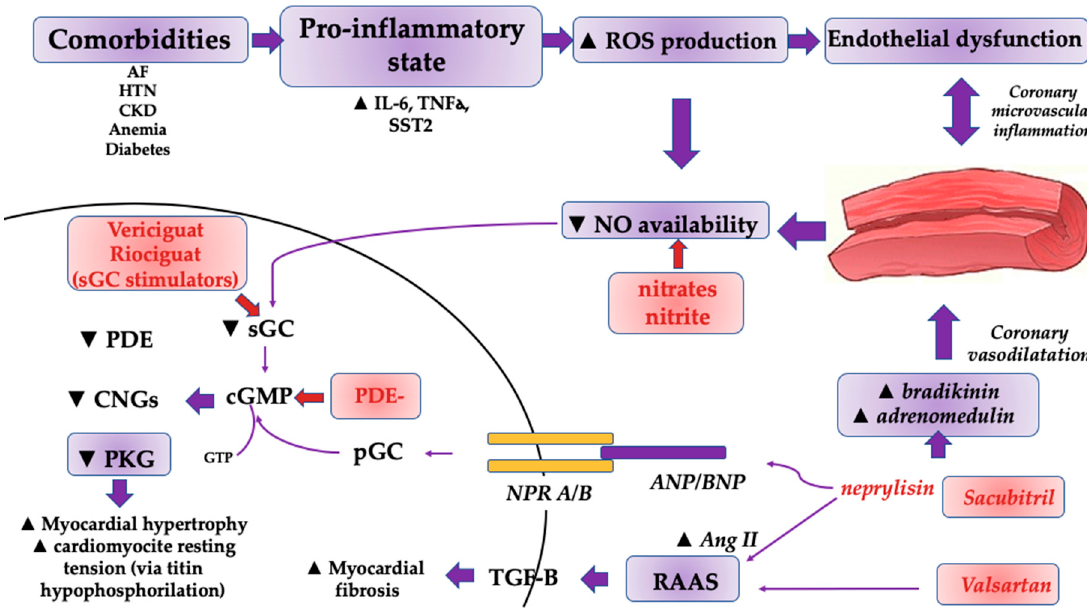
Figure 1. NPs, cGMP and RAAS in HFpEF patients and possible therapeutic targets. AF: atrial fibrillation; Ang II: angiotensin II; cGMP: cyclic guanosine monophosphate; CKD: chronic kidney disease; CNGs: cyclic nucleotide gated-ion channels; HTN: hypertension; IL: interleukin; NO: nitric oxide; NP: natriuretic peptide; NPR: natriuretic peptide receptor; pGC: particulate guanylyl cyclase; PKG: protein kinase G; PDE: phosphodiesterase; PDE-: phosphodiesterase inhibitors; RAAS: renin-angiotensin-aldosterone system; sGC: soluble guanylyl cyclase, TGF-B: transforming growth factor beta. Table 2. The biological characteristics of natriuretic peptides. ANP- atria natriuretic peptide; BNP- B 201 type natriuretic peptide; CNP- C-type natriuretic peptide; *values may vary slightly across studies. 202